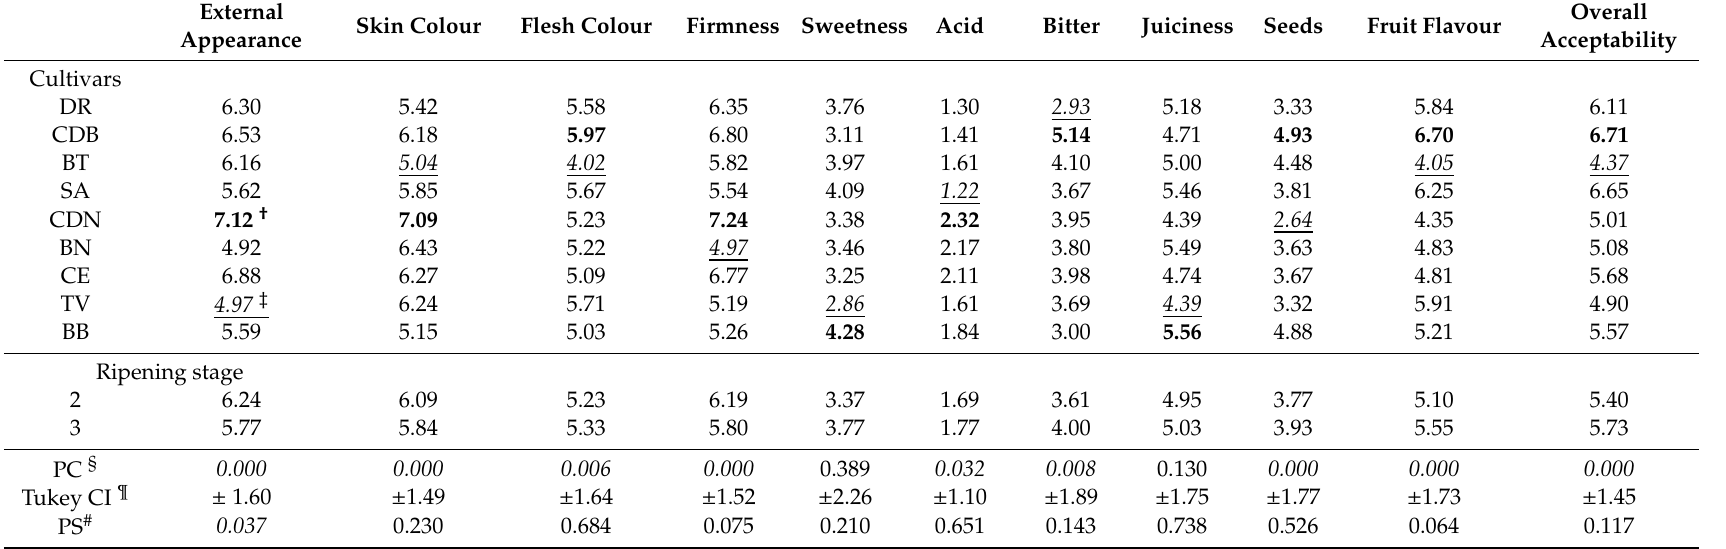
Table 2. Scores of the sensory descriptive attributes and overall acceptability for the samples of the di ff erent cultivars studied and for ripening Stages 2 and 3. External Skin Colour Flesh Colour Firmness Sweetness Acid Bitter Juiciness Seeds Fruit Flavour Appearance